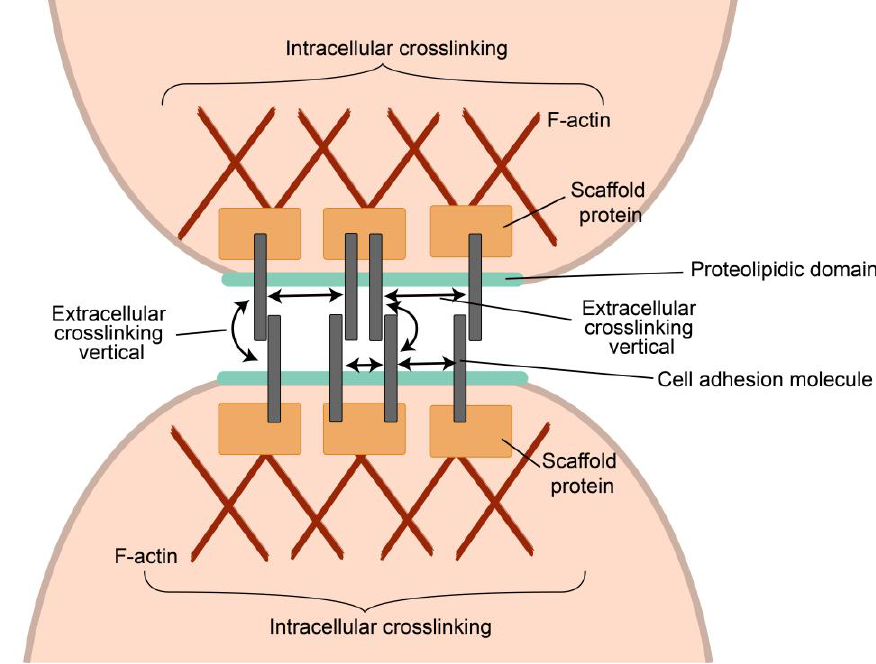
Figure 5. Schematic illustration of application of bi-valent cross-linkers or ligands for modification of clusters connecting the interacting cells.